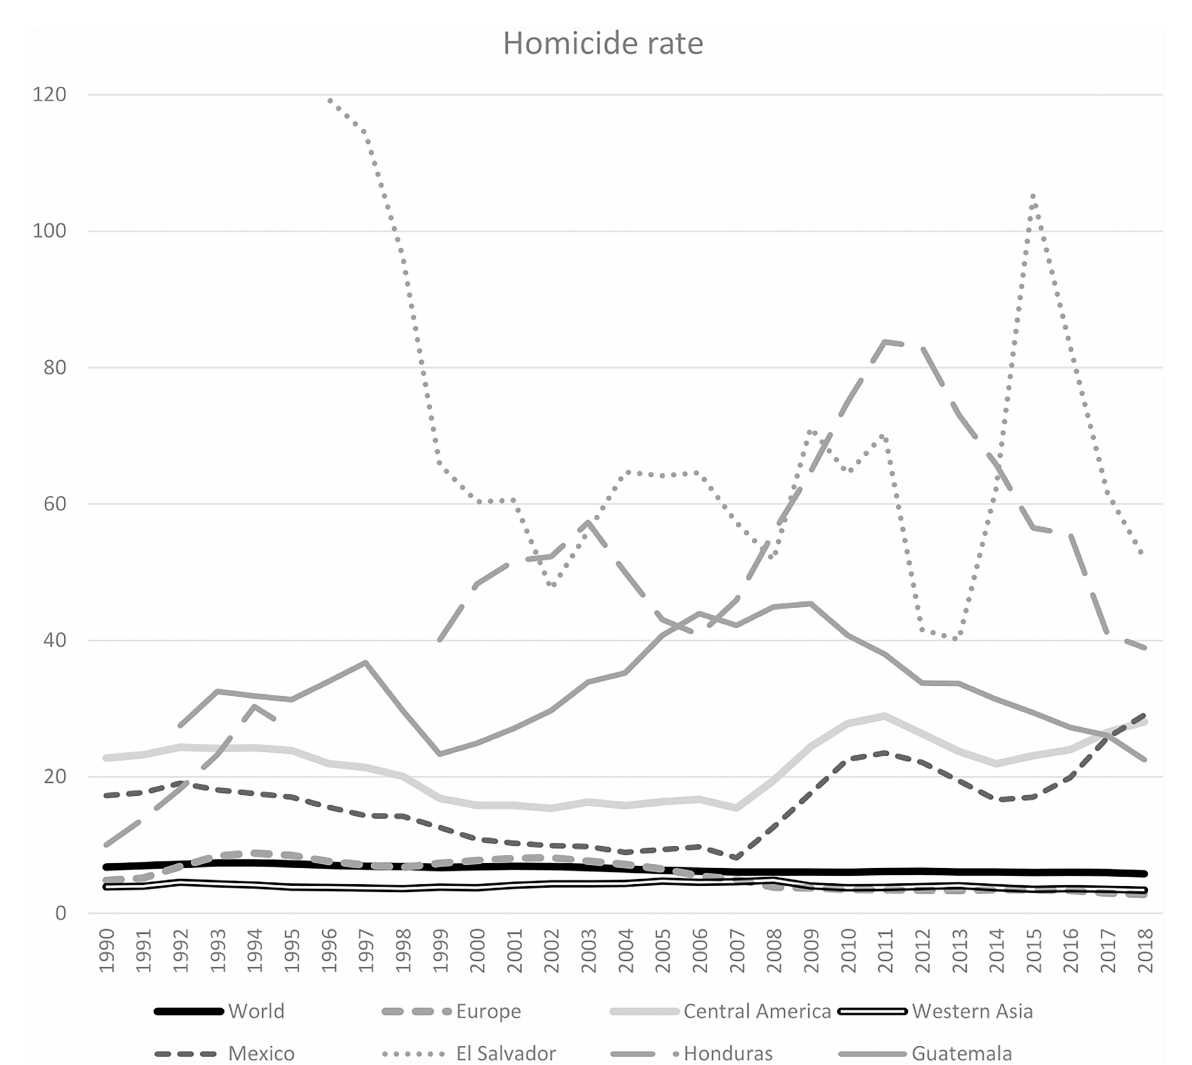
FIGURE2 Homicide rate: world, regions, and countries. Source: Own elaboration based on https://dataunodc.un.org/data/homicide/Homicide%20victims %20worldwide.